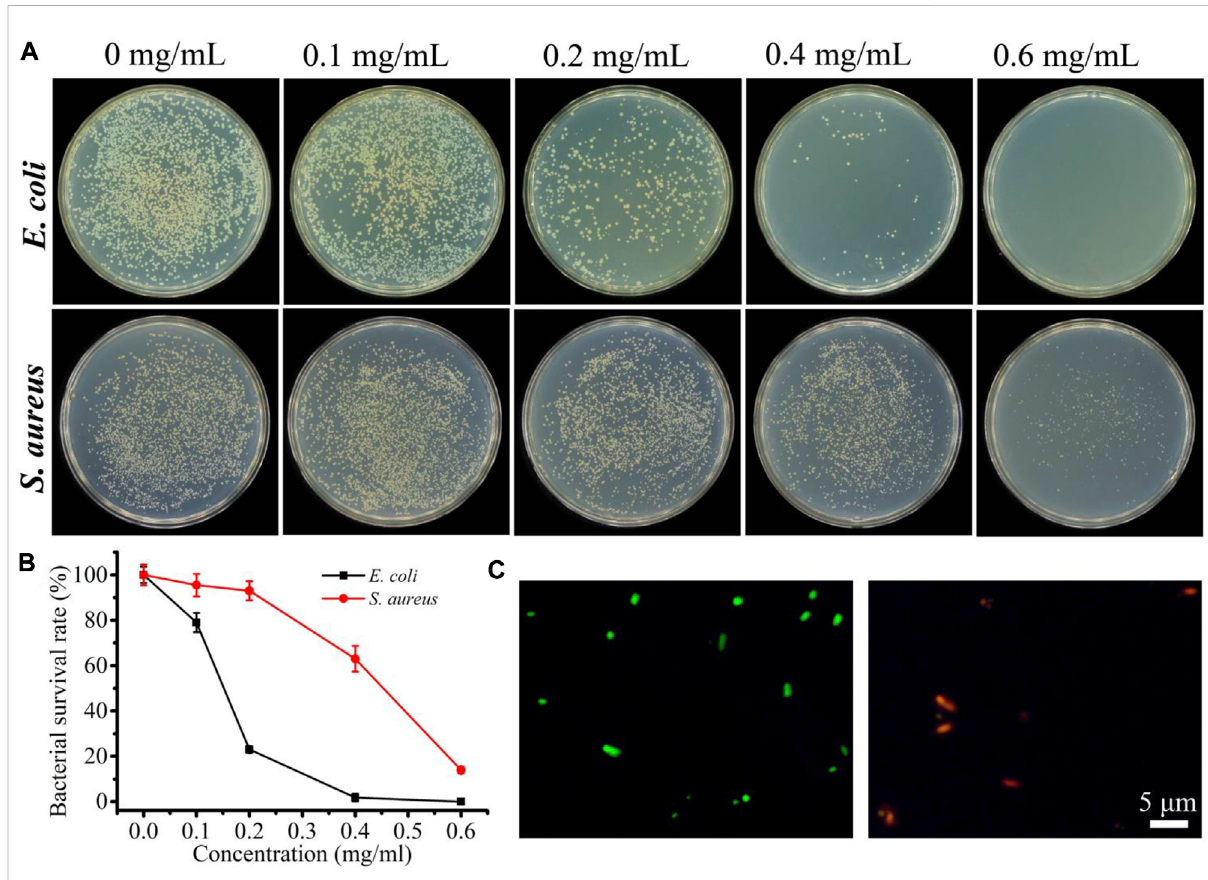
FIGURE 4 (A) Photograph of the colonies of E. coli and S. aureus treated with different concentrations of UTH in the presence of 1 mM H 2 O 2 under 900- nmlightirradiation. (B) Correspondingbacterialviabilitiesbycounting (A) . (C) Fluorescenceimages(stainedwithSYTO9andPI)of E.coli before(left) and after (right) being treated with UTH in the presence of H 2 O 2 under 900-nm light